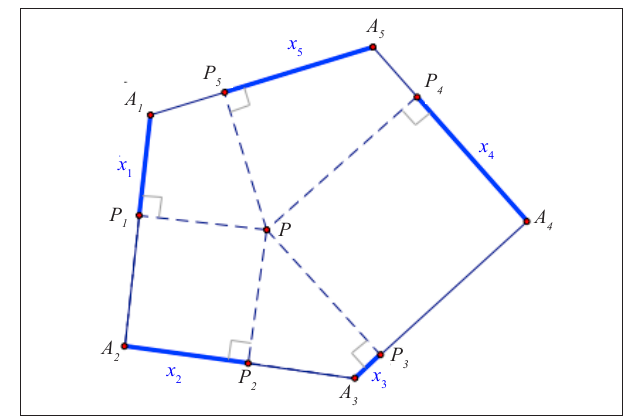
FIGURE 4: An equilateral pentagon.